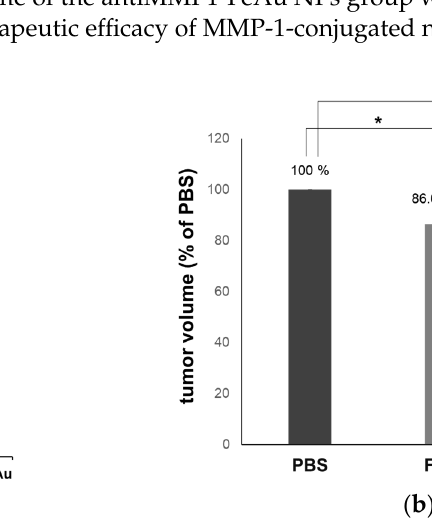
Figure 6. The in vivo anti-cancer effects magnetic heat after 30 days. ( a ) The tumor volume % of original; ( b ) the tumor volume % of PBS (control groups). Statistical analysis was performed using two-tailed student’s t -test and the level of significance was set at 0.05. * represents p -value ≤ 0.05 and ** represents p -value ≤